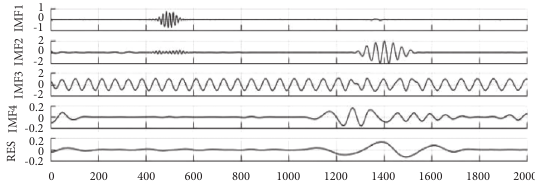
Figure 15: Decomposition of the simulation signal by